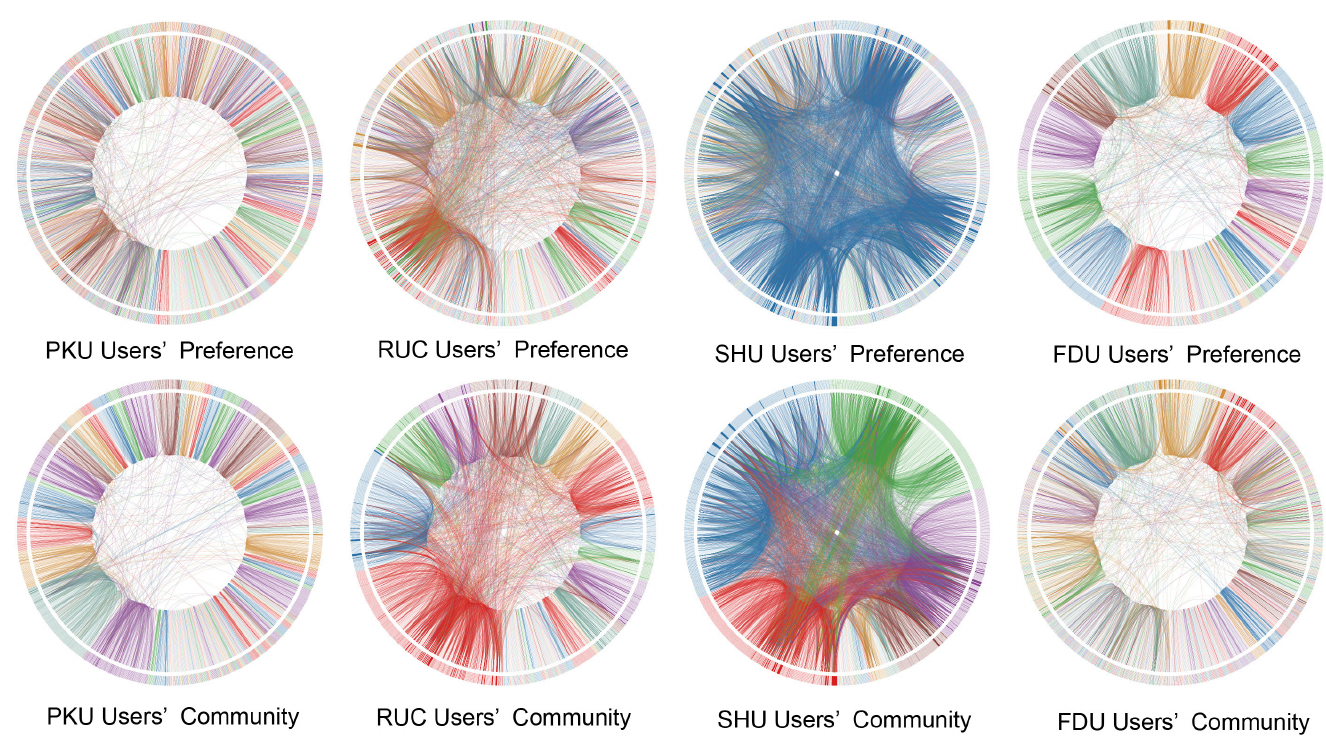
Fig 3. Visual comparison of board-preferred polarizations (upper panel) to algorithmically identified communities (lower panel) for four universities. All the nodes follow the same order in the same university. The colors of the nodes in the upper panel indicate preferred boards, while they indicate communities in the lower panel. The colors of the links is selected randomly from the color of the connected